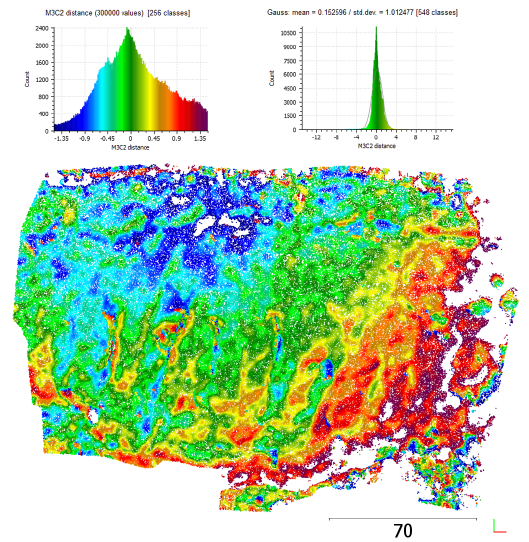
Figure 7. M3C2 comparison between the thermal and visible models. The beach is located at the upper part of the figure.